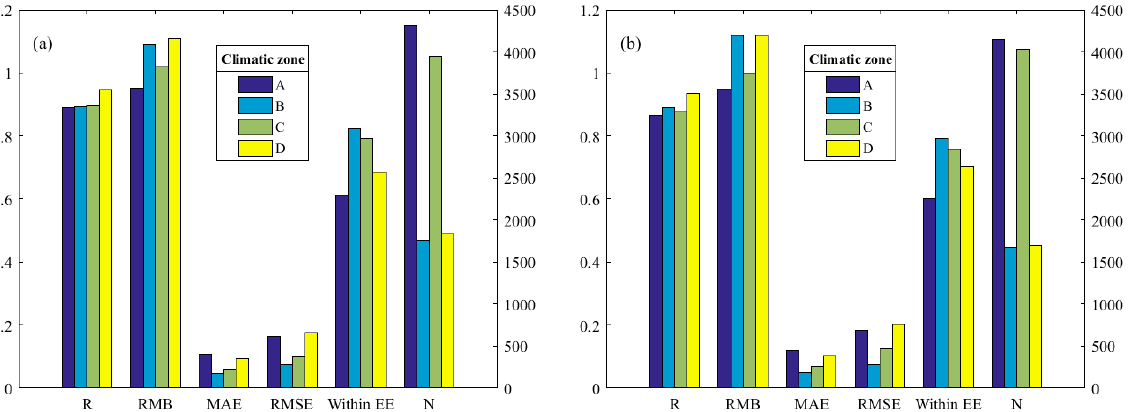
Figure 6. Comparison of accuracy of AOD observations for MAIAC Terra ( a ) and Aqua ( b ) against AERONET measurements in different climate zones.